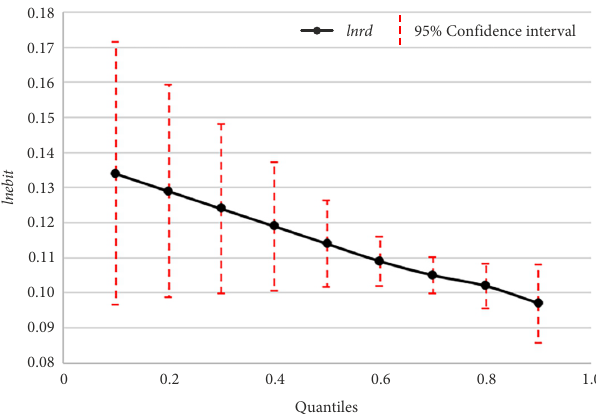
Figure A1. Effect of R&D input on economic performance